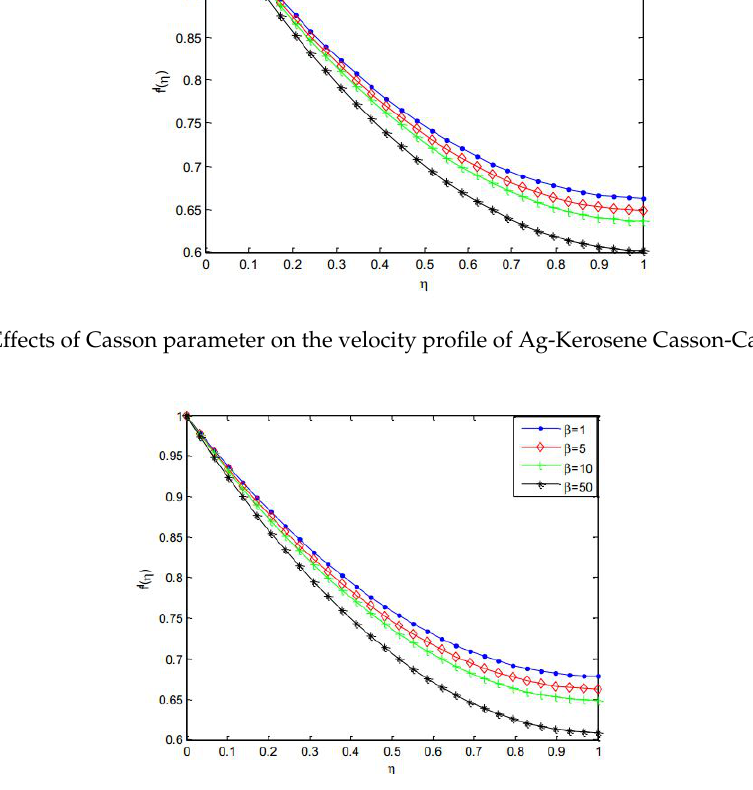
Figure 5. Effects of Casson parameter on temperature profile of Cu-Kerosene Casson-Carreau